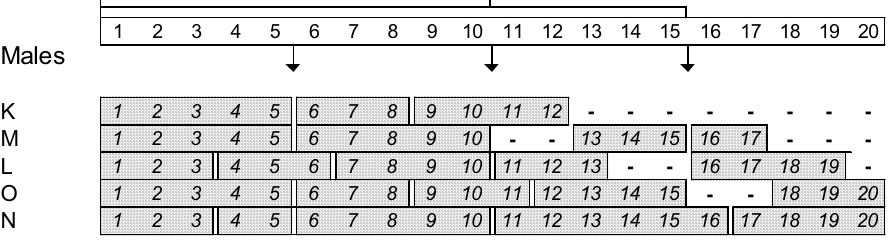
Fig. 5 – Imitations (italic numbers) and their sequential associations (song-packages, stippled areas) de- veloped by the birds K-O from strings presented in the experiment ‘novelty cueing’. Symbols of master song-types are given on top. Arrows indicate the sequential locations where new substrings were added and where package boundaries were expected if cueing occurred. Acquisition failures are given by